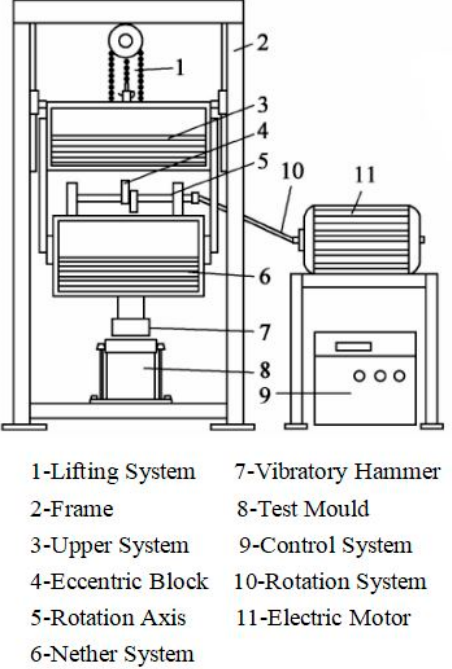
Figure 1. The structure of the vertical-vibration-testing machine.